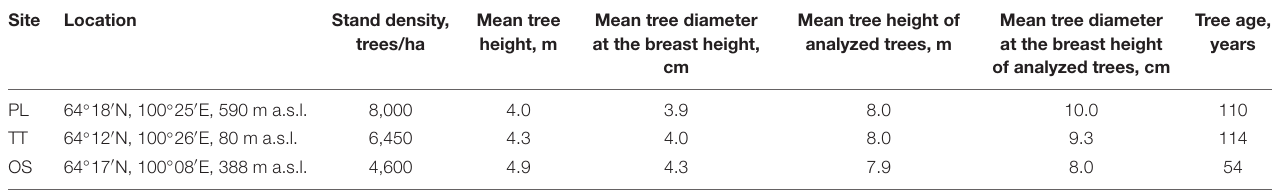
TABLE 1 | Description of the studied stands. Site Location Stand density,